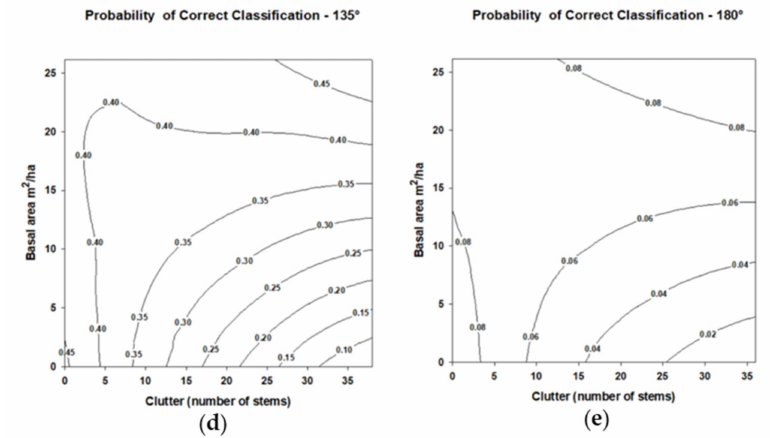
Figure 7. Contour graph for generalized linear model results of synthetic bat echolocation playback response within an anechoic chamber displaying the probability of Kaleidoscope Pro (Version 4.2.0, Wildlife Acoustics, Maynard, MA, USA) correctly classifying received pulses as an eastern red bat ( Lasiurus borealis ) in relation to stem density (stem count) and basal area (m 2 /ha) for detector angles ( a ) 0 ◦ , ( b ) 45 ◦ , ( c ) 90 ◦ , ( d ) 135 ◦ , and ( e ) 180 ◦ , Blacksburg, VA, USA, 2016 (see text for